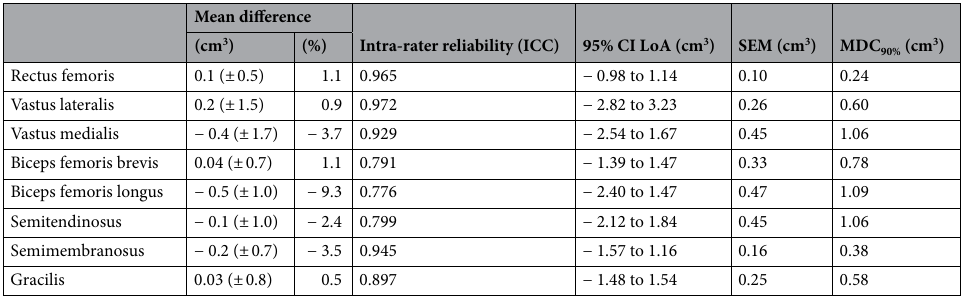
Table 2. Intra-rater reliability measurements for the thigh muscles of infants aged 6 months and younger as measured by two raters; rater 1 (analysis of the knee extensor muscles) and rater 2 (analysis of the knee flexor muscles). Percentage mean difference was calculated based on mean muscle volumes. LoA limits of agreement, SEM standard error of measurement, MDC minimum detectable change.